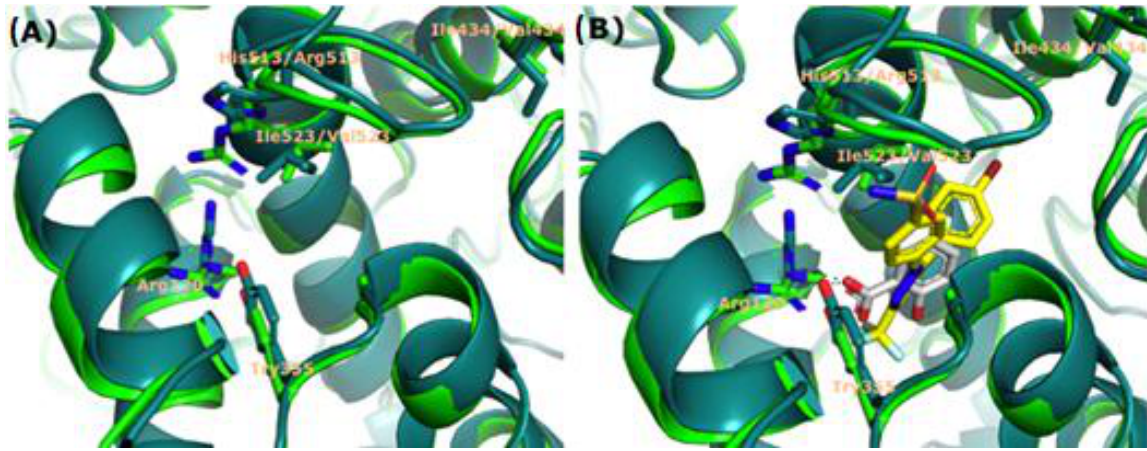
Figure 3. Crystallographic structures of COX-1 (1PTH; light green line) and COX-2 (1CX2; dark green line). ( A ) Major changes in isoforms 1 and 2 (Hist513Arg; Ile434Val and Ile523Val) and residues Arg120 and Try355, responsible for interaction with NSAIDs available in therapy; ( B ) Aligned structures of COX-1 and COX-2 bound to salicylic acid (white) or SC-558 (yellow), which interact with residues Arg120 and Try355,